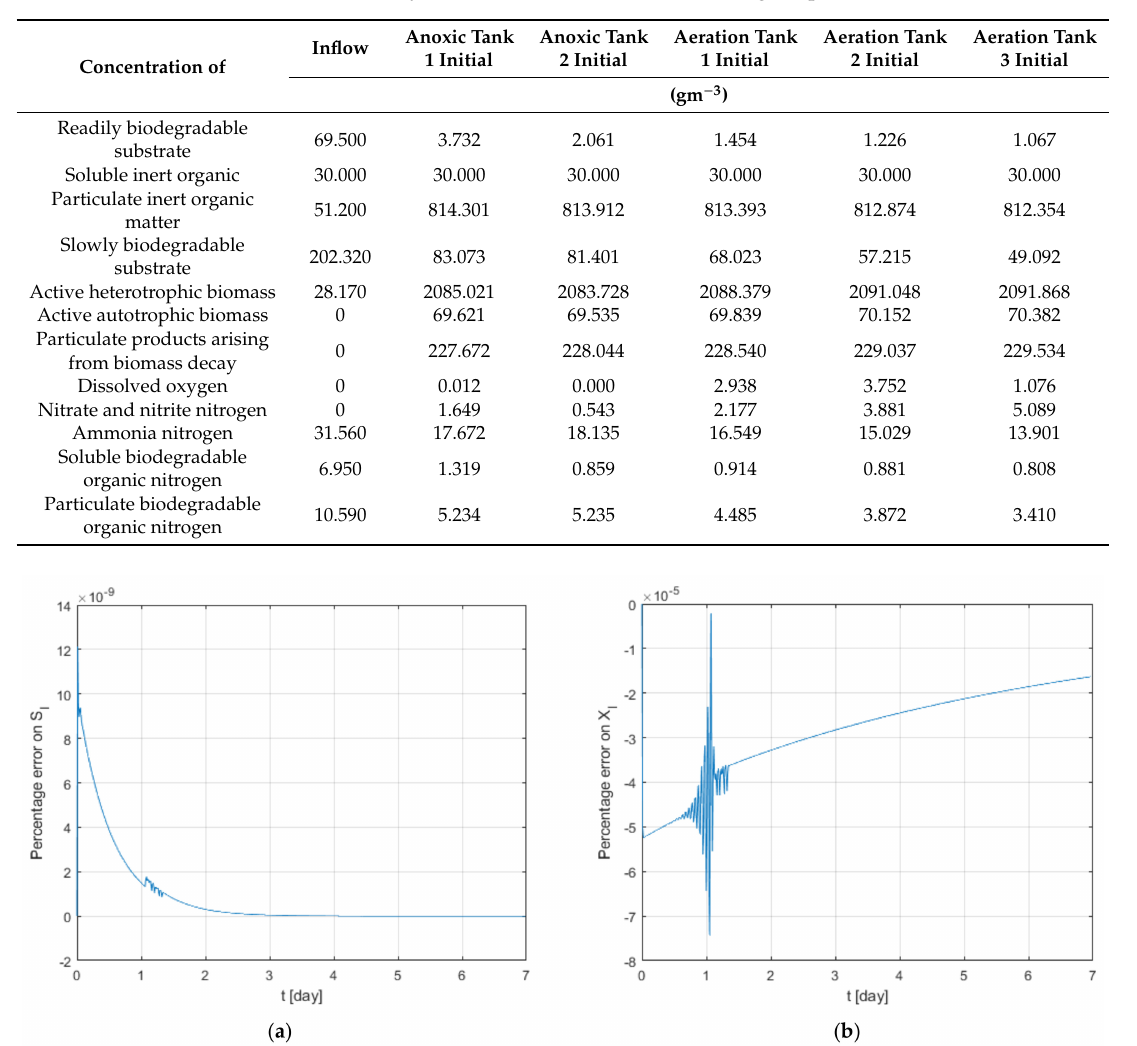
Table 1. Boundary and initial conditions in the biological process.